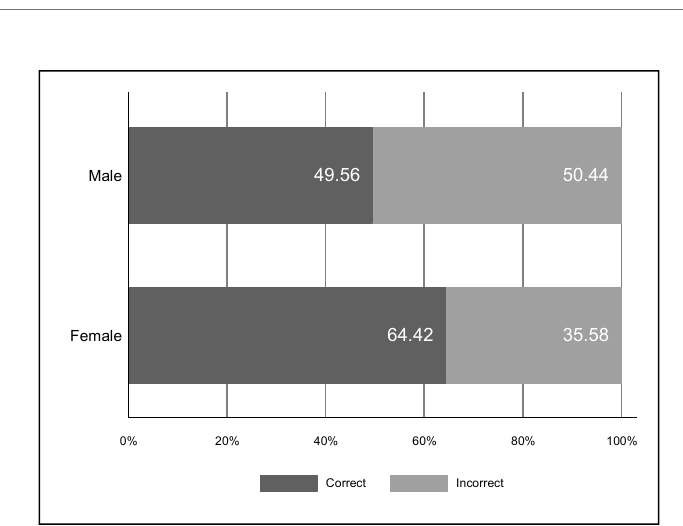
Figure 3 Interviewer behavior for collecting administrative information I and interviewer’s gender